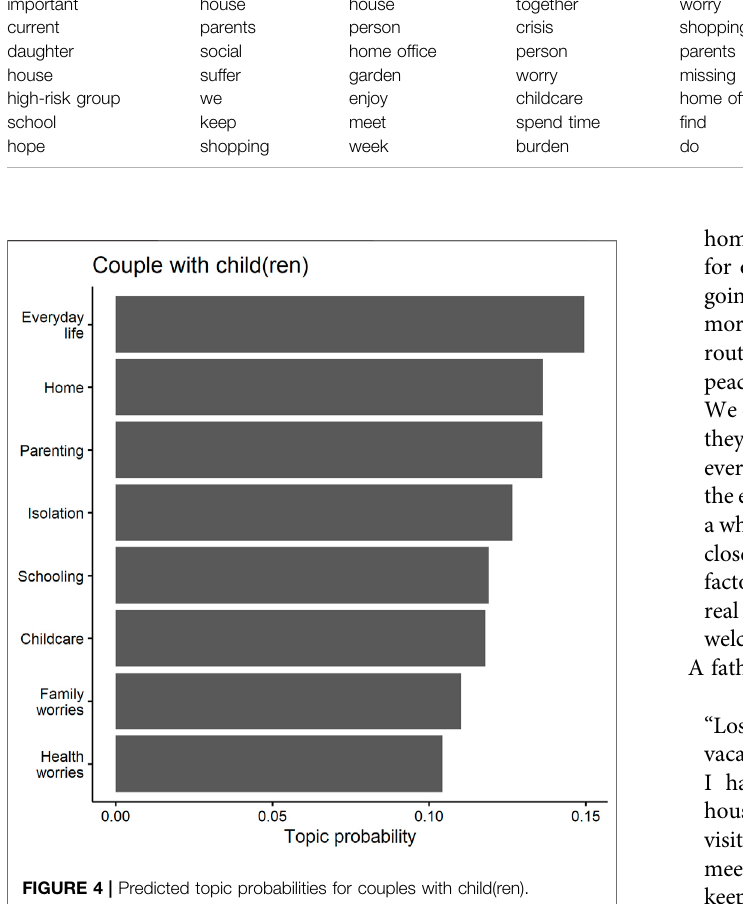
FIGURE 4 | Predicted topic probabilities for couples with